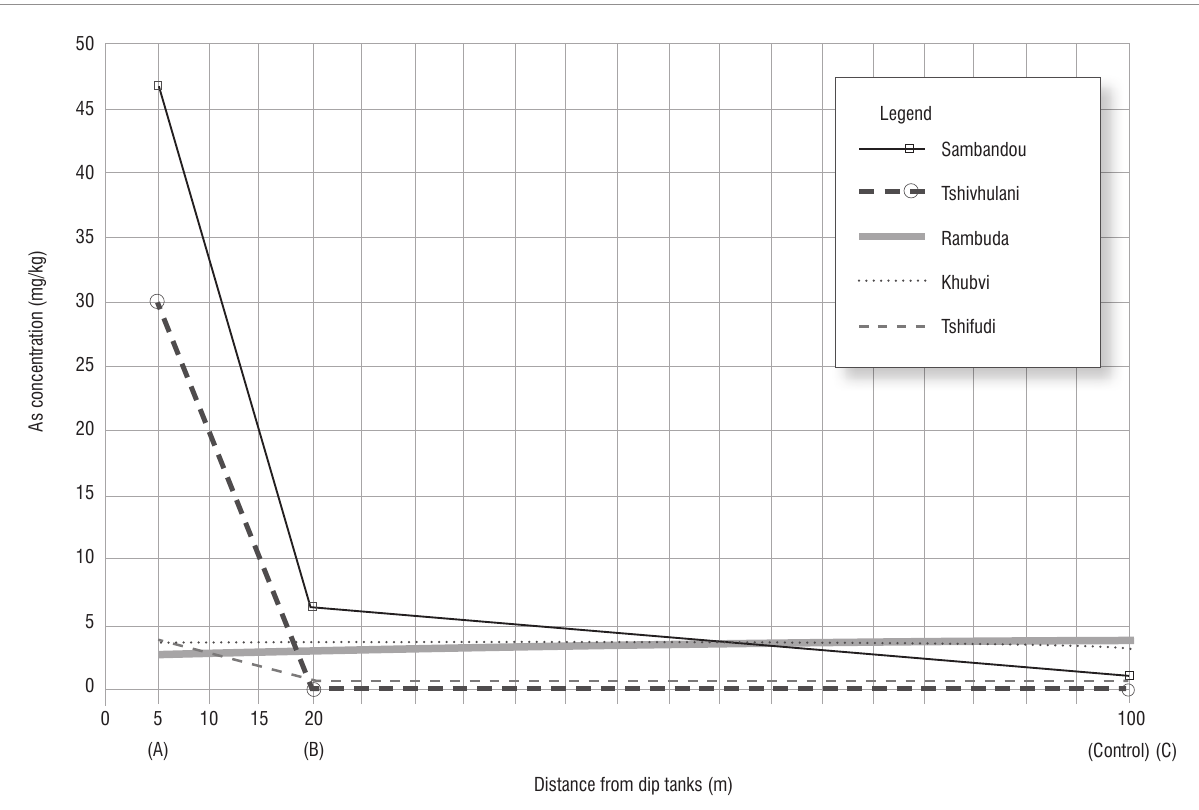
Distance from dip tanks